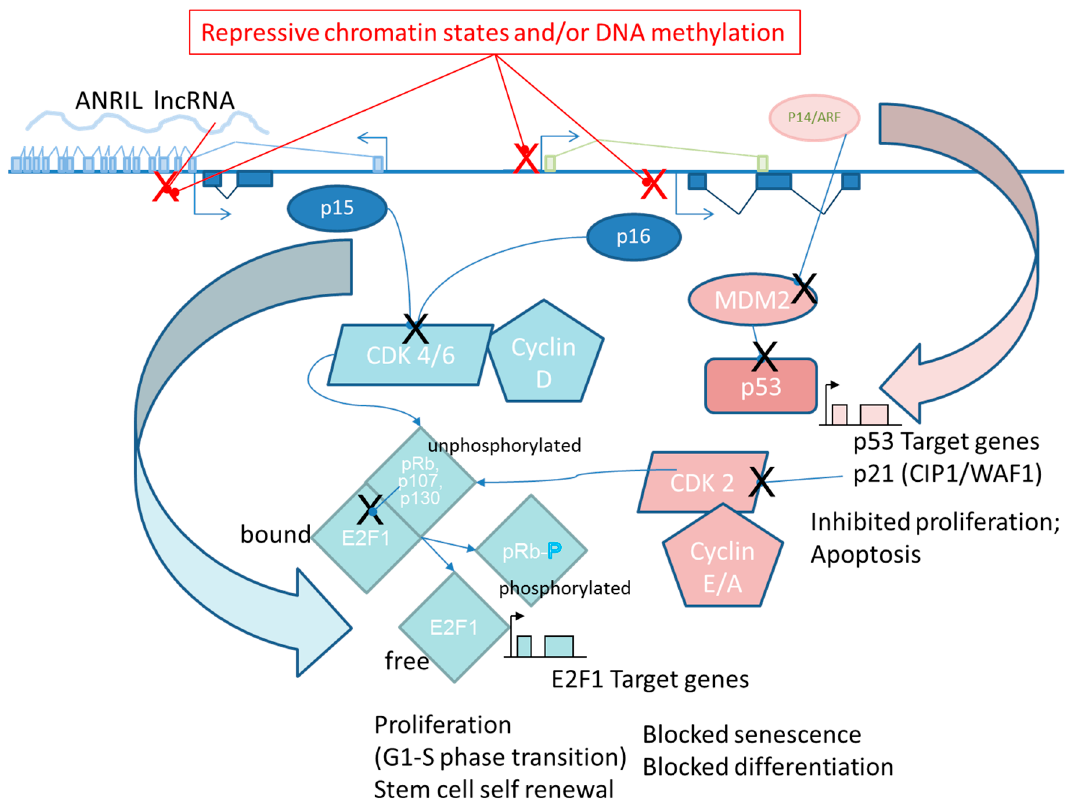
Figure 1. Schematic representation of the human 42 Kb INK4-ARF ( CDKN2A/B ) locus (not to scale) and its participation in two pathways controlling cell-cycling and differentiation. Two pathway branches leading to tumor suppression originate from the locus, influencing E2F1 transcription factor availability (large blue arrow) and the p53 protein stability (large red arrow). Suppressive chromatin states and/or DNA methylation (red Xs) can silence gene expression from the locus. Expression of p16 and p15 is controlled by a collection of activating and repressive transcription factors (not shown). When expressed, p16 and p15 bind to cyclin-dependent kinases (CDK4 and CDK6) which inhibits their phosphorylation of the retinoblastoma tumor suppressor protein (pRB) (small bule arrows). Hypophosphorylation of pRB and its homologues (p107, p130) due to lack of cyclin-dependent kinase activity allows them to sequester E2F1 transcription factor and prevent its transport to the nucleus, where it would otherwise activate a battery of genes involved in cell proliferation and stem cell renewal. Expression of p14/ARF inhibits the E3 ubiquitin ligase activity of MDM2 (mouse double minute 2) thereby stabilizing p53 transcription factor, resulting in up-regulated expression of its target genes promoting apoptosis and inhibiting proliferation. One p21 inhibitor of CDK2 (cyclin-dependent kinase 2) which targets pRB. One important cross connection between the two branches is indicated, operating through the cyclin-dependent kinase inhibitor, p21/CIP1/WAF1. Normal inhibitory interactions between components within the two pathways are indicated by black Xs. Not indicated are many other interconnections between the two signaling circuits that provide both complexity and redundancy to the pathways, a topic covered more thoroughly by references provided herein.